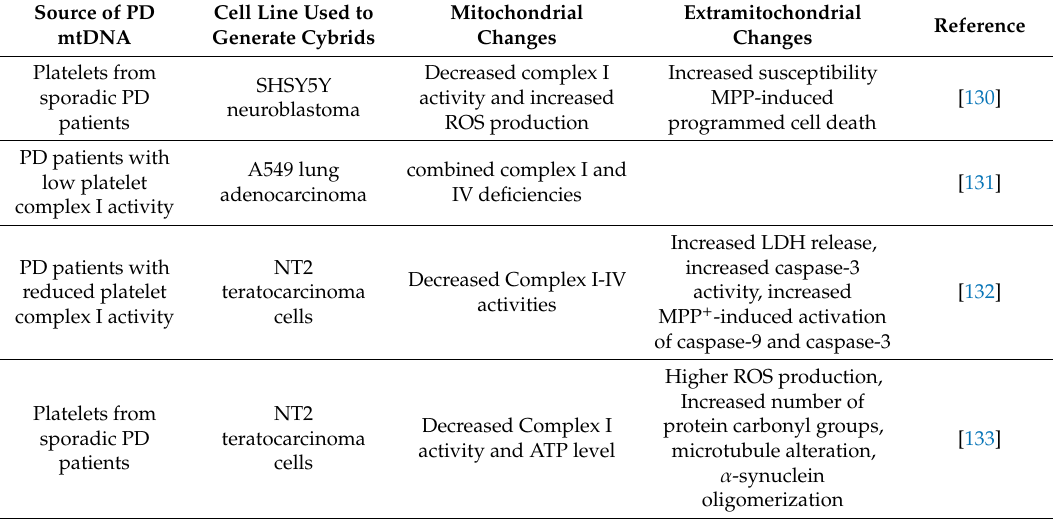
Table 3. The role of mtDNA alterations in the mitochondrial dysfunction and extramitochondrial processes evaluated in PD cybrid